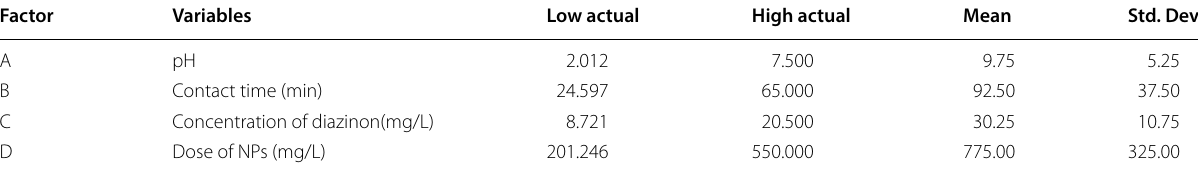
Table 2 The levels of variables central composite statistical experiment design